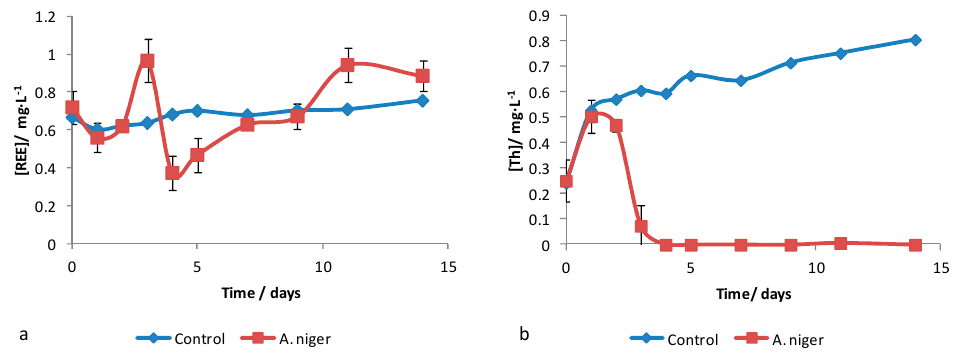
Figure 6. Evolution of REE ( a ) and thorium concentration released ( b ) from monazite (1 g / L) in abiotic and biotic ( A. niger )